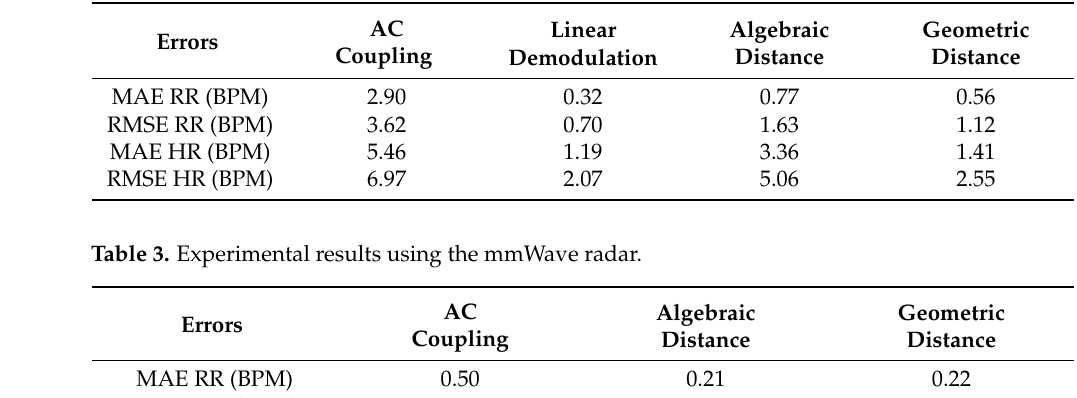
Figure 5. Bland–Altman comparisons of the references and the mmWave radar. ( a ) RR and ( b ) HR with the AC Coupling method. ( c ) RR and ( d ) HR with the geometric fitting method. Finally, we report the average MAEs and RMSEs in Tables 2 and 3. Table 2. Experimental results using the sub-10 GHz radar.